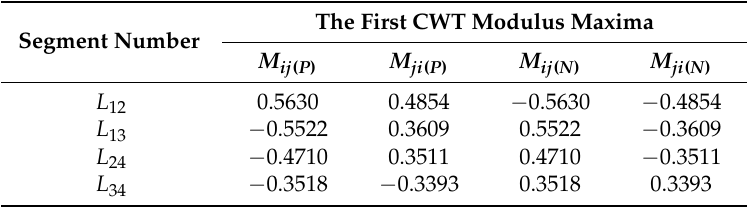
Table 3. Simulation results of WT modulus maxima.